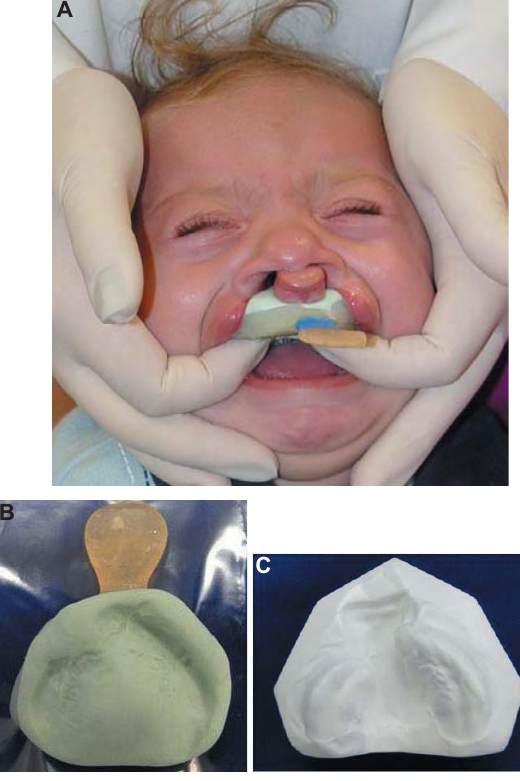
Figure 1 A-C - Impressions and plaster models of the maxillary dental arch for diagnosis and treatment plan (parents authorized the publication of this